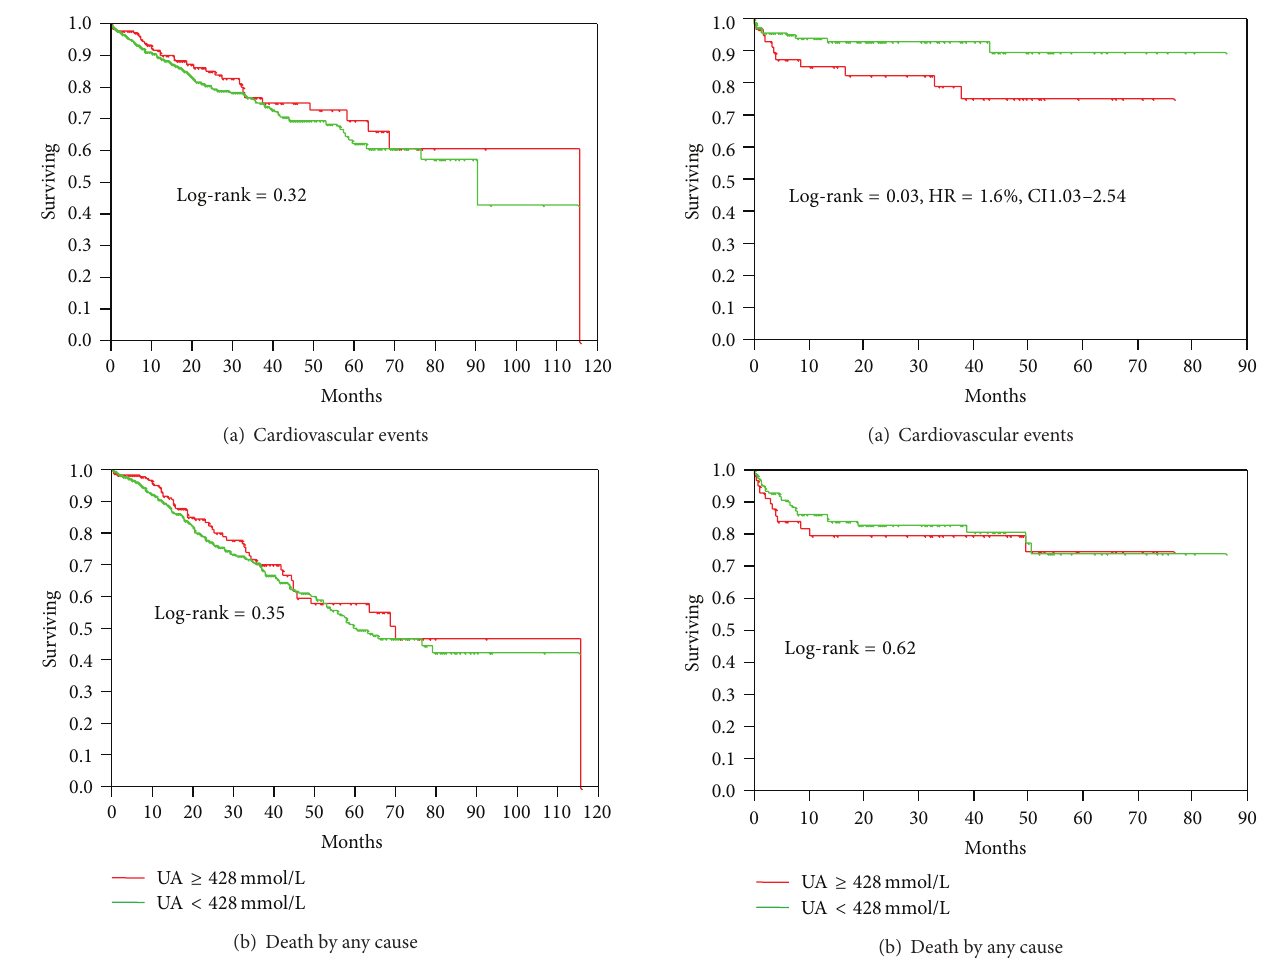
Figure1:(a)and(b)Cardiovasculareventsandmortalityinpatients on the waiting list for renal transplantation according to uric acid level. Table4:ResultsofCoxregressionmodelwithcardiovascularevents as dependent variable in renal allograft recipients.